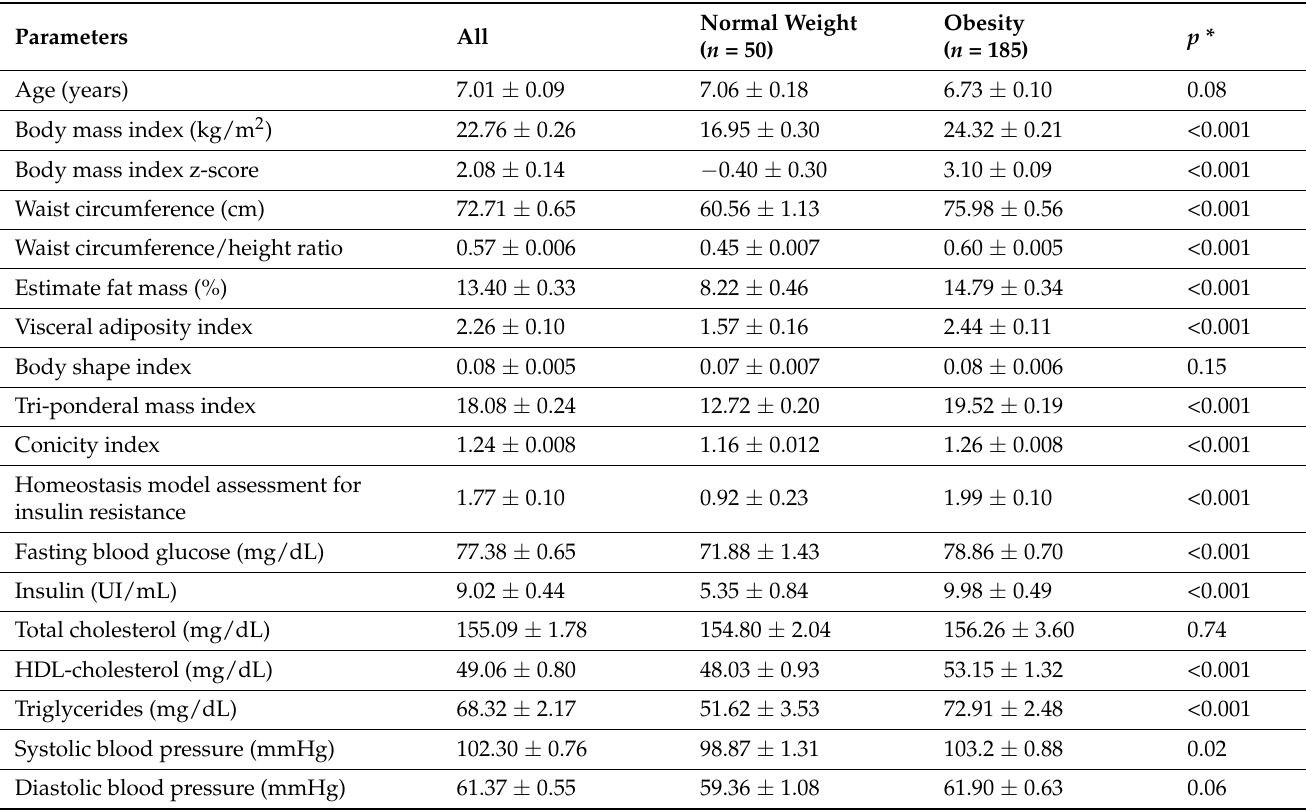
Table 1. Clinical and biochemical data in obese and normal-weight